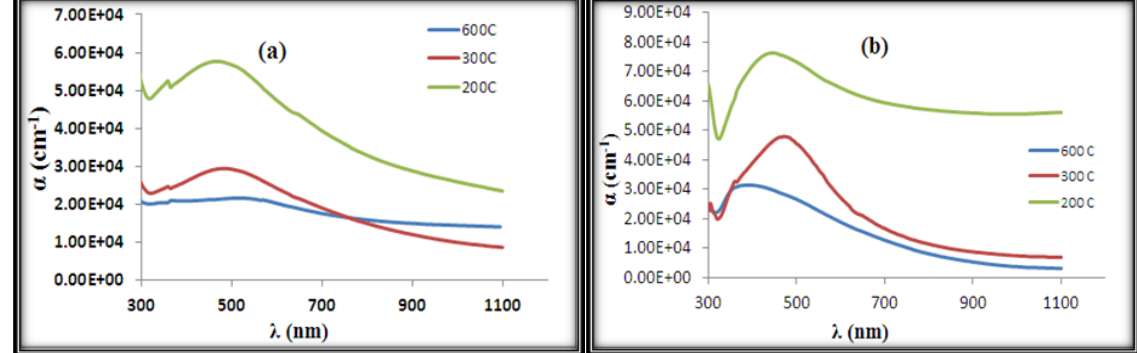
Fig.11: Absorption coefficient versus wavelength of Ag temperature (a) as deposited (b) annealed at 200 °C for half an